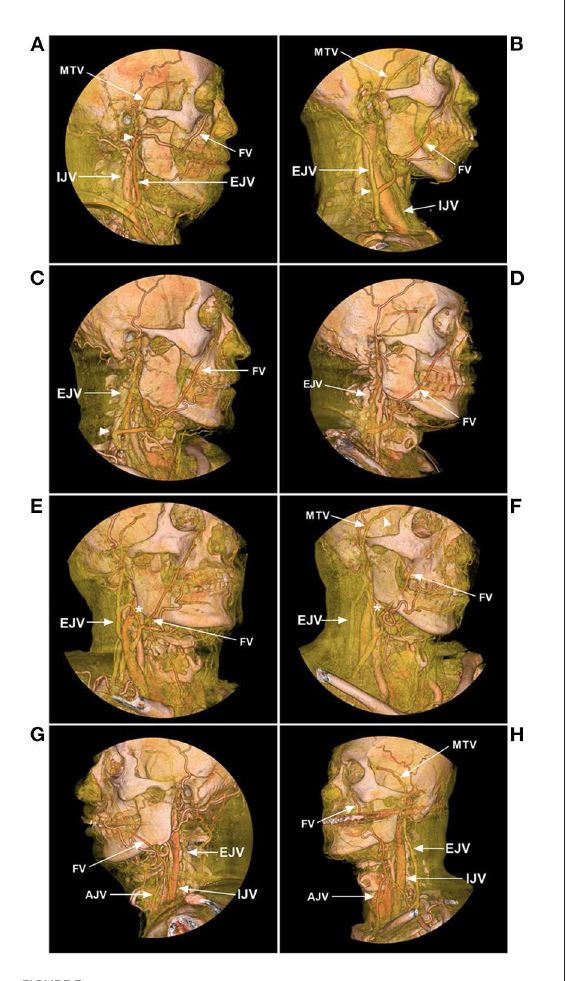
FIGURE3 FV variance of CTA. (A) Lateral view CTA shows that the FV courses posteriorly and combines with the MTV at the mandibular joint (arrowhead) from the EJV. (B) Lateral view CTA shows that the FV descends obliquely and curves around the inferior edge of the mandible and flows into the EJV at the middle cervical region (arrowhead). (C) Lateral view CTA shows that the FV flows into the EJV in the low cervical region (arrowhead). (D) Lateral view CTA shows that the FV descends obliquely and curves around the inferior edge of the mandible and flows into the subclavian vein without connection with the IJV or EJV. (E, F) Oblique view CTAs shows that the FV flows into the subclavian vein with the connection with the EJV (asterisks). (G, H) Oblique view CTAs shows that the FVs mainly flow into the AJVs, with the connection with the EJVs. AJV, anterior jugular vein; CTA, computed tomography angiography; EJV, external jugular vein; FV, facial vein; IJV, internal jugular vein; MTV, middle temporal